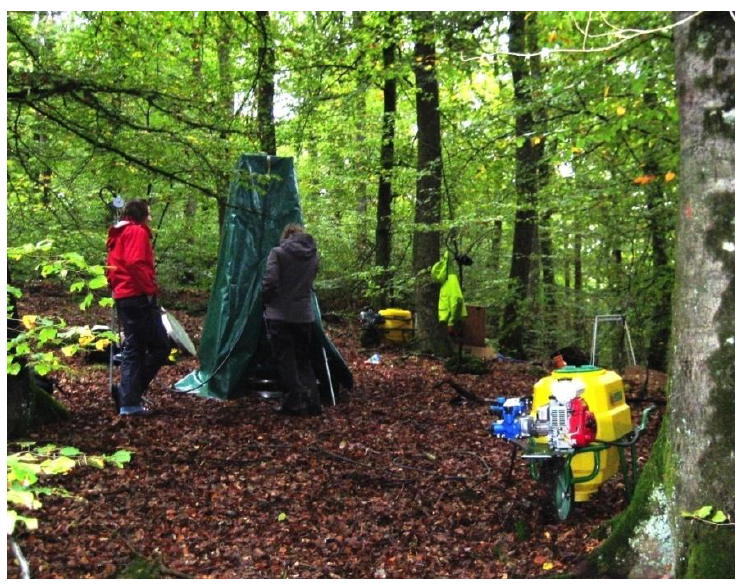
Figure 4. Small portable rainfall simulator with water tank-pump combination (yellow; foreground) and nozzle-linkage-tarpaulin system (green).